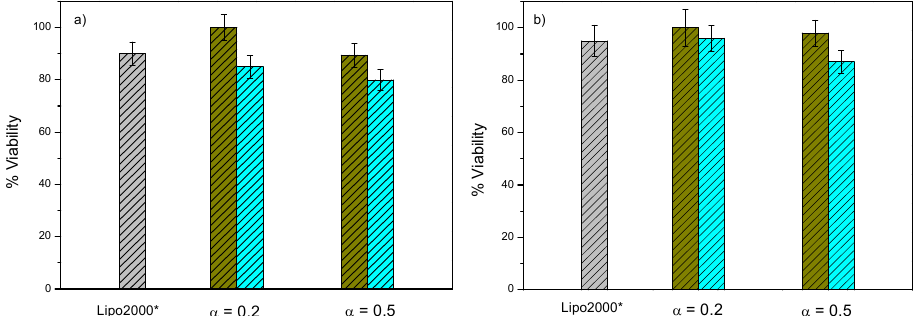
Figure 6. Cell viability of COS-7 cells in the presence of C 3 (C 16 His) 2 /DOPE-pDNA lipoplexes at two molar fractions of the C 3 (C 16 His) 2 cationic lipid in the C 3 (C 16 His) 2 /DOPE mixed lipid ( α = 0.2 and 0.5): ( a ) with pCMV-Luc plasmid and ( b ) with pEGFP-C3 plasmid. The green and blue bars correspond to effective charge ratios ρ eff = 4 and 10 of the lipoplex, respectively. Gray bar: Lipo2000* as the positive control. The data represent the mean ± SD of three wells and are representative of three independent